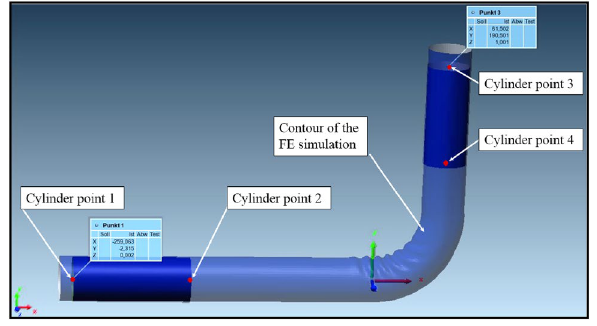
Fig. 12 Influence of axis stiffness on wrinkle formation in